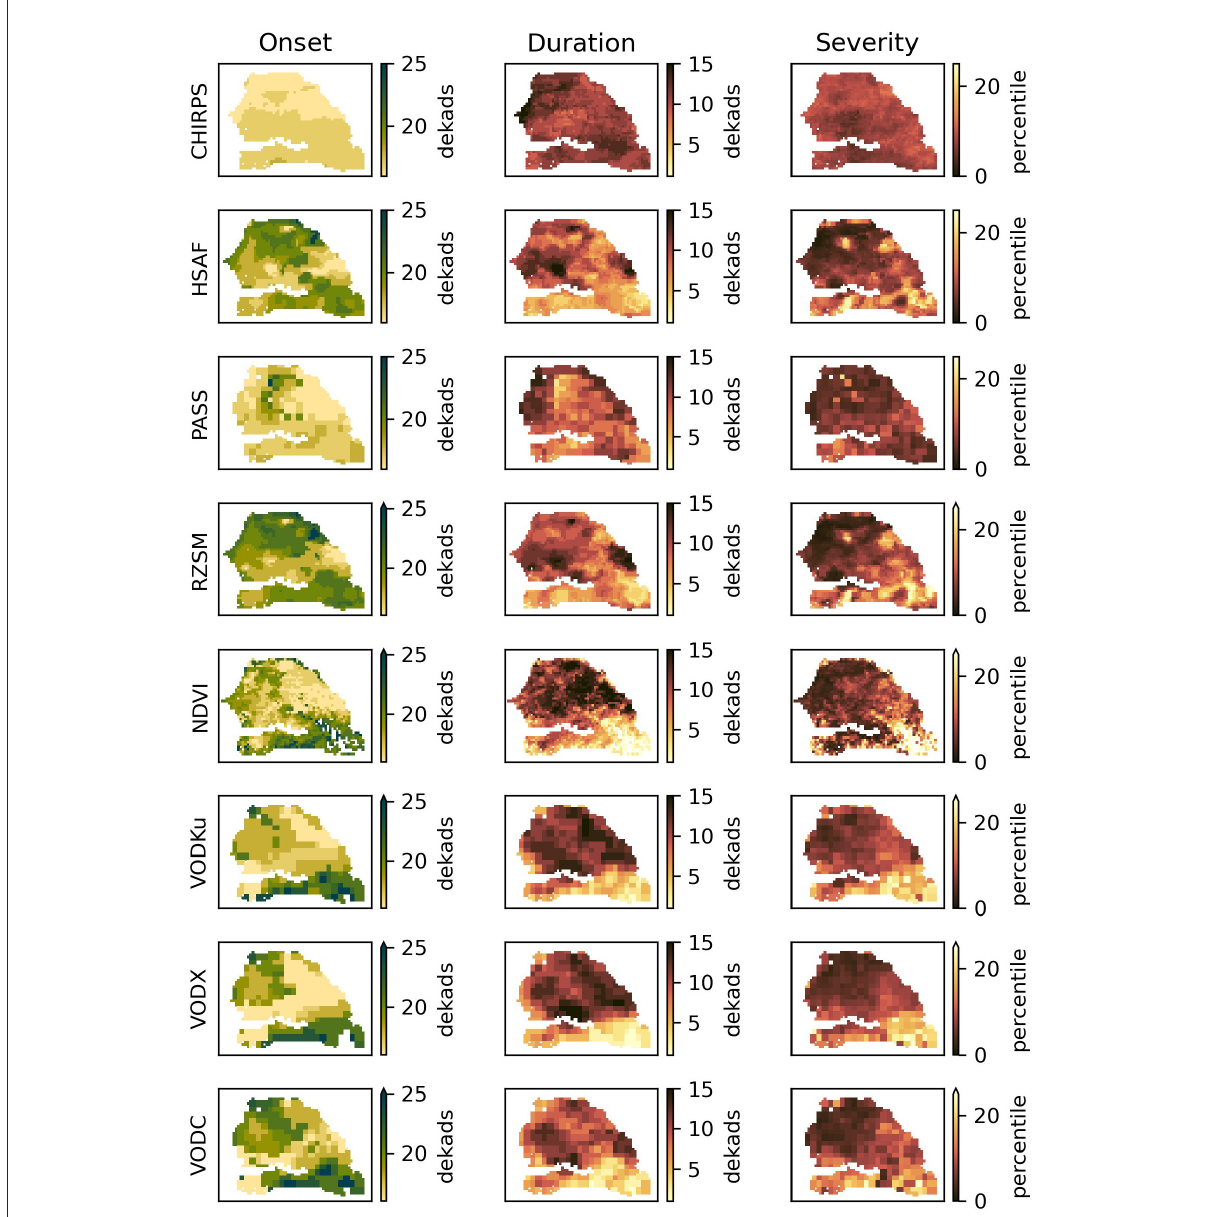
FIGURE4 Statistics for the 2014 Senegal drought in terms of onset, duration and severity as captured by rainfall, SM and vegetation datasets.